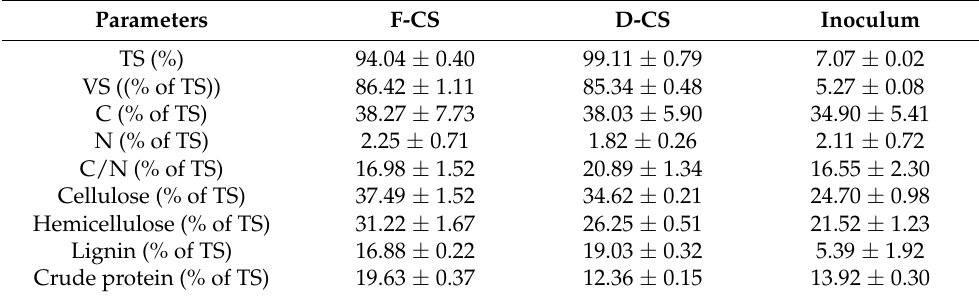
Table 2. Basic physicochemical characteristic parameters of raw materials.